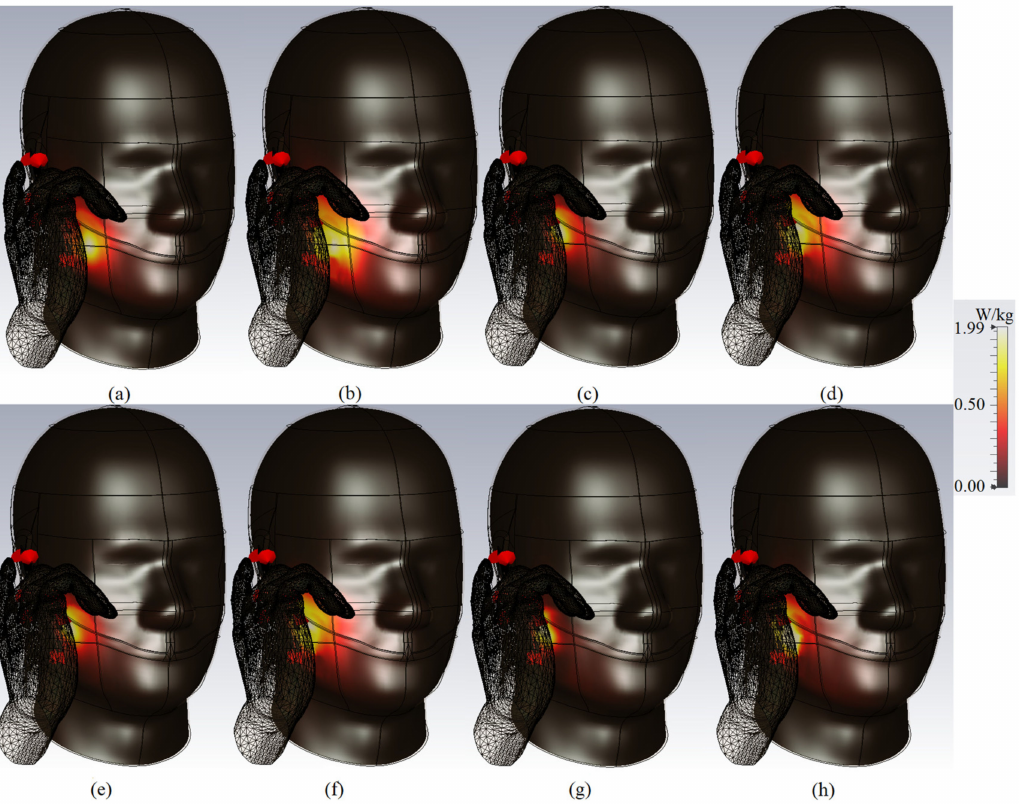
Figure 22. Specific Absorption Rate (SAR) distribution for MIMO elements on head and hand models: ( a ) 1g and ( b ) 10 g at 3.8 GHz; ( c ) 1g and ( d ) 10g at 5.2 GHz; ( e ) 1g and ( f ) 10 g at 5.4 GHz; ( g ) 1g and ( h ) 10g at 8.0 GHz.